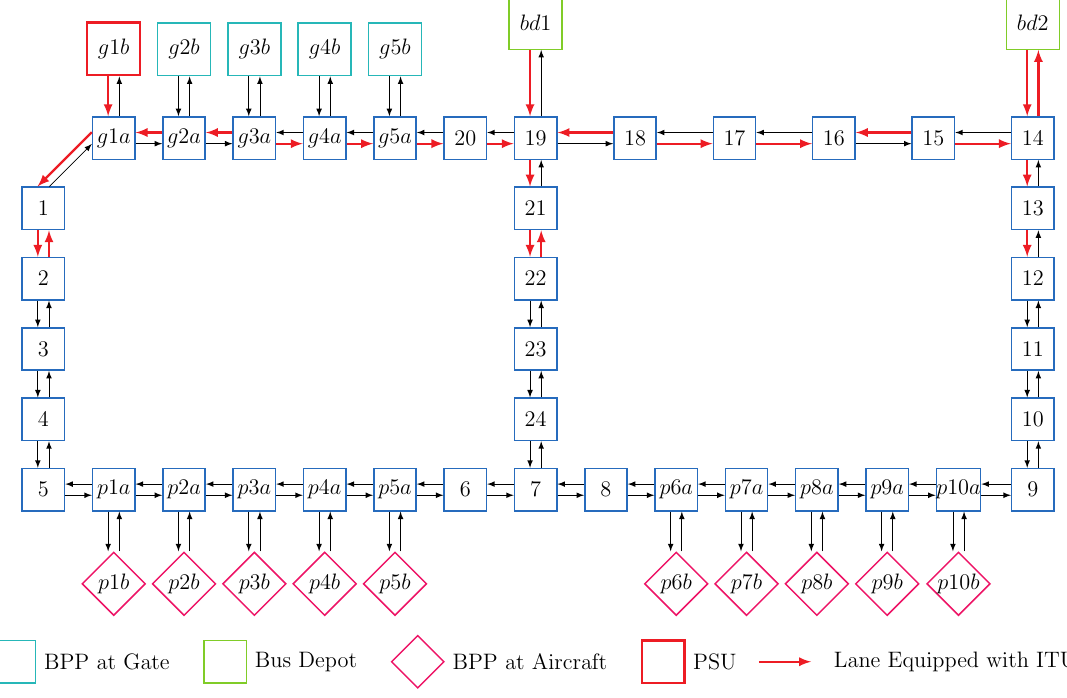
Figure 11. Allocation of system components for Case B (relatively expensive